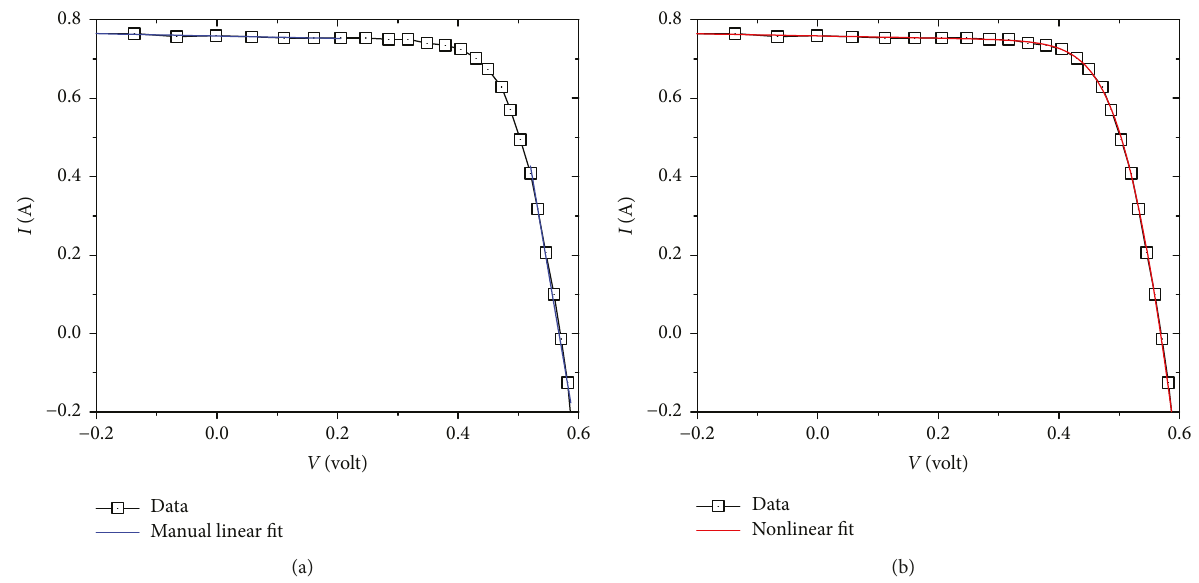
Figure 4: I-V curve fi t on a silicon solar cell module (Photowatt-PWP-201) using the manual method (a) and nonlinear curve fi t using the Shockley equation (b).